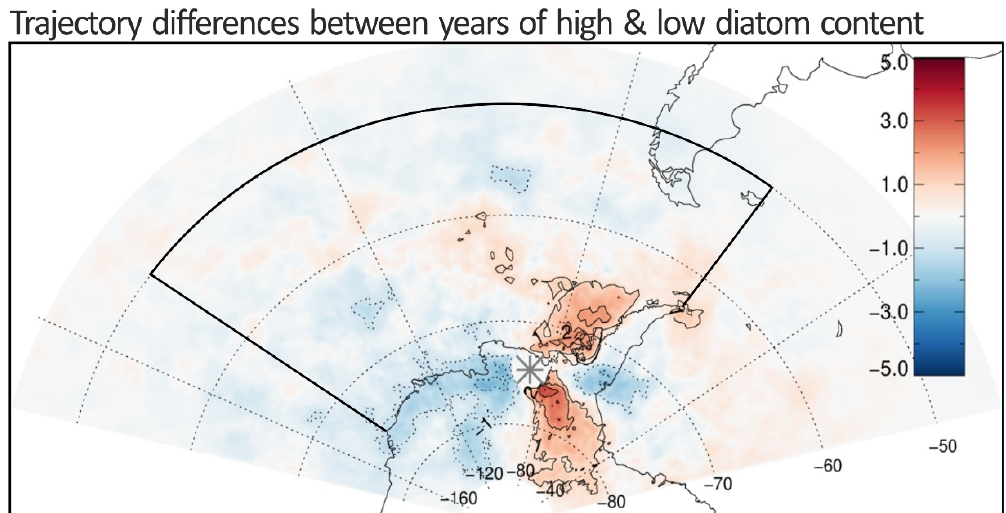
Figure 7. Map showing the difference between back-trajectories for years with the 12 highest (red shading) and 12 lowest (blue shading) diatom abundance; presented as a percentage of all trajectories (see Figure 5a). Heavier shading illustrates higher proportion (%) of trajectories. Grey star indicates the location of the Ferrigno ice core and black outline replicates the demarcation of the Amundsen and Bellingshausen Seas given in Figure 1.